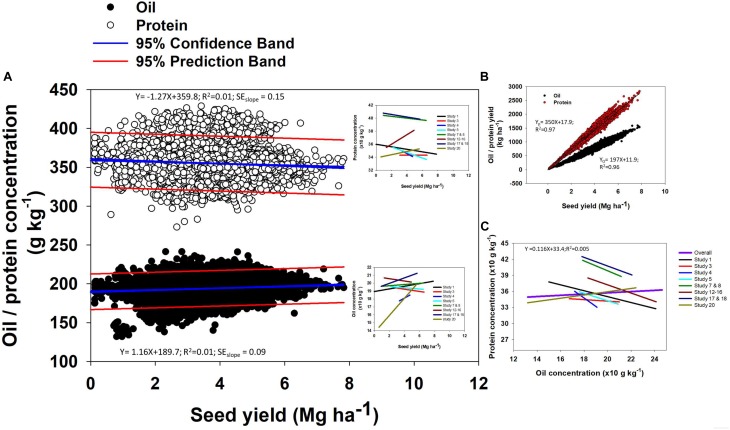
Relationships between oil and protein concentration with seed yield (A), seed yield with oil and protein yield (B), and protein concentration and oil concentrations (C). Study numbers are in the order presented in Table 1.